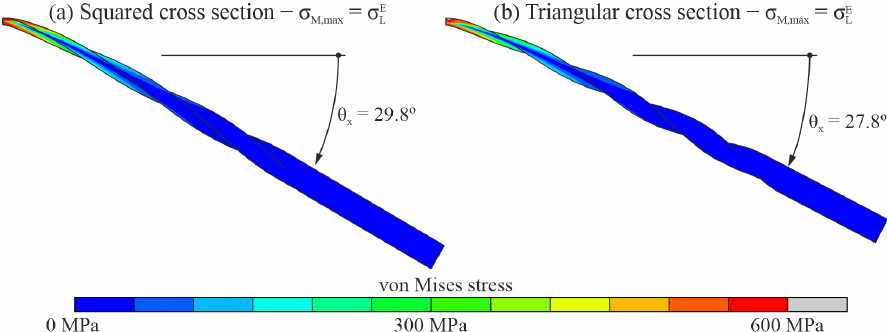
Figure 5. The von Mises stress plots for the bending analysis of endodontic files with p z = 4 mm and ϕ = 0 ◦